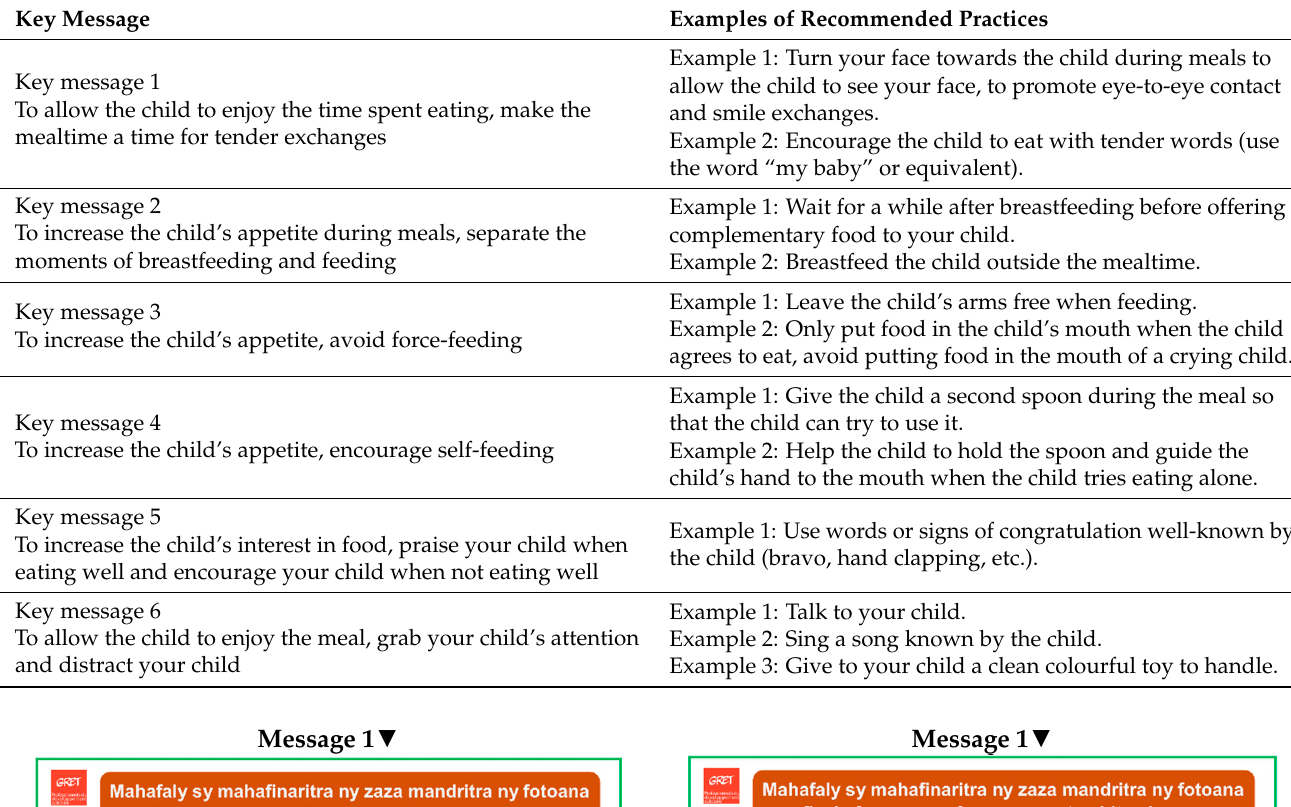
Table 8. Six key messages proposed for the promotion of responsive feeding and the corresponding examples of recommended practices.